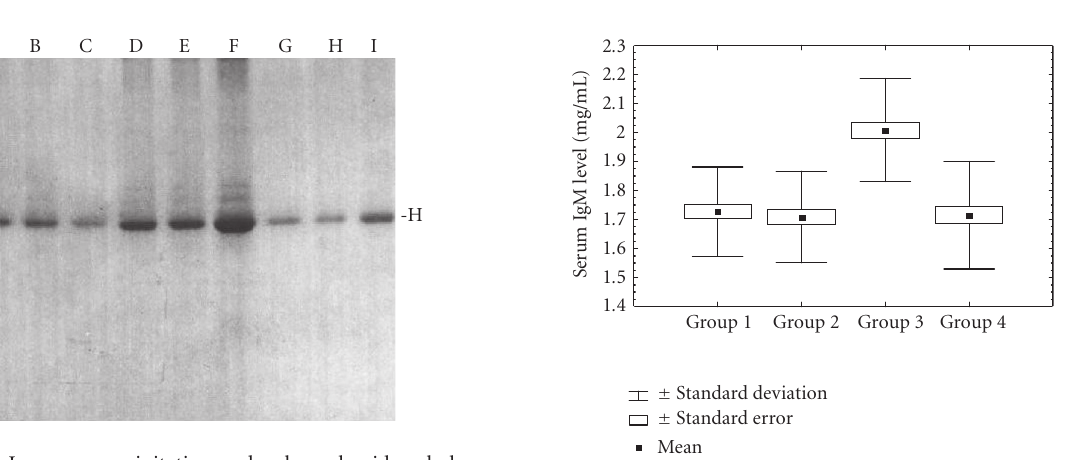
Figure 1. Immuno-precipitation and polyacrylamide gel elec- trophoresis of human serum samples with anti-human IgM. Three HEV-infected serum samples were immuno-precipitated with anti-IgM antiserum developed in rabbit in the absence (lanes A, B, and C resp) or presence of BSA (lanes F, E, and D resp). Lane H contained one normal serum sample in the ab- sence of BSA and Lane G contained the same normal serum sam- ple in the presence of BSA. Lane I represents standard human IgM. H indicates positions of immunoglobulin heavy chains. The precipitates were washed, dissolved in Laemmli sample bu ff er, and analyzed by polyacrylamide gel electrophoresis.